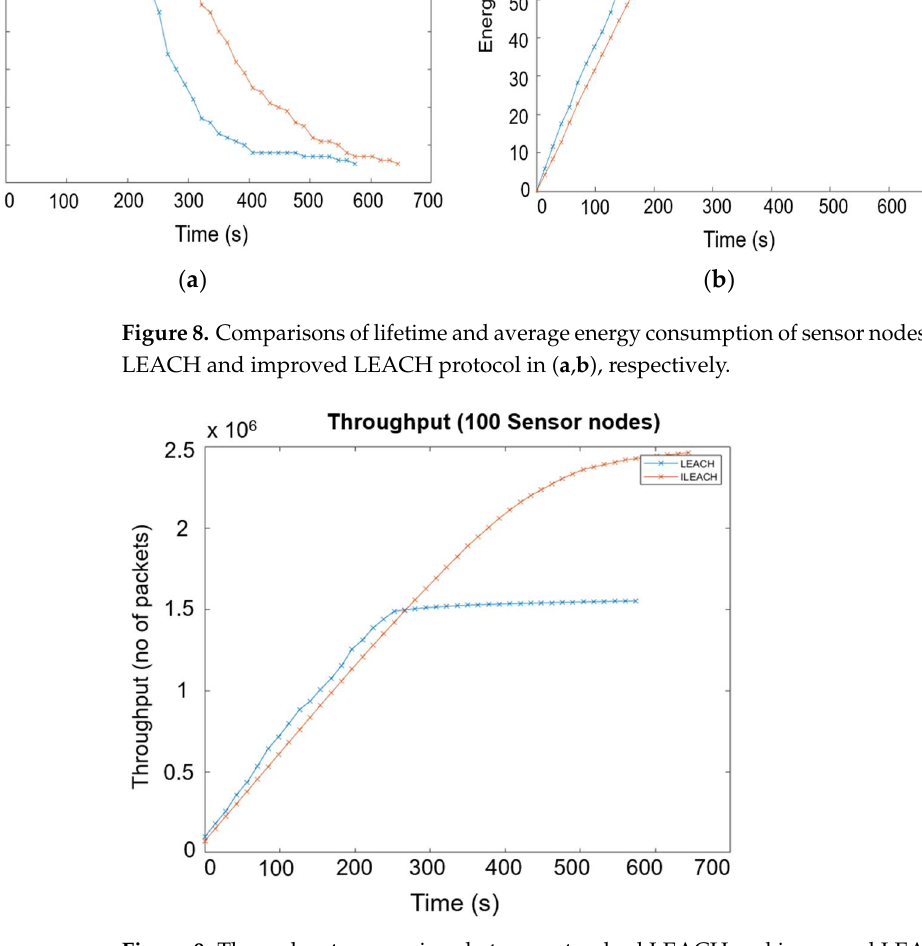
Figure 9. Throughput comparison between standard LEACH and improved LEACH protocol.